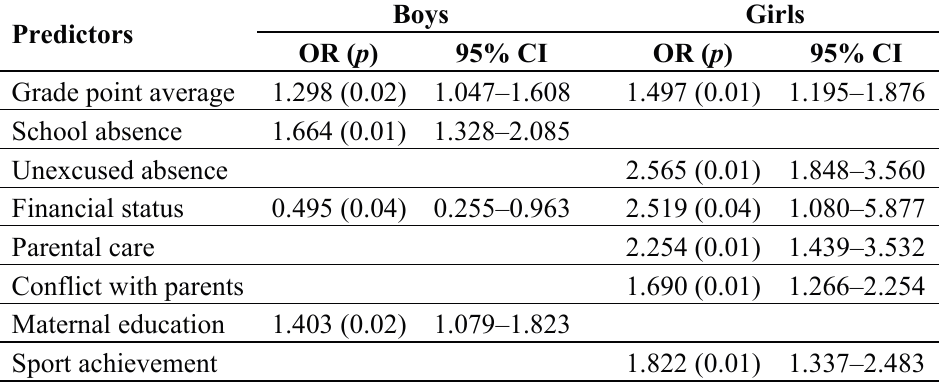
Table 2. Forward conditional logistic regression results for the criterion—harmful